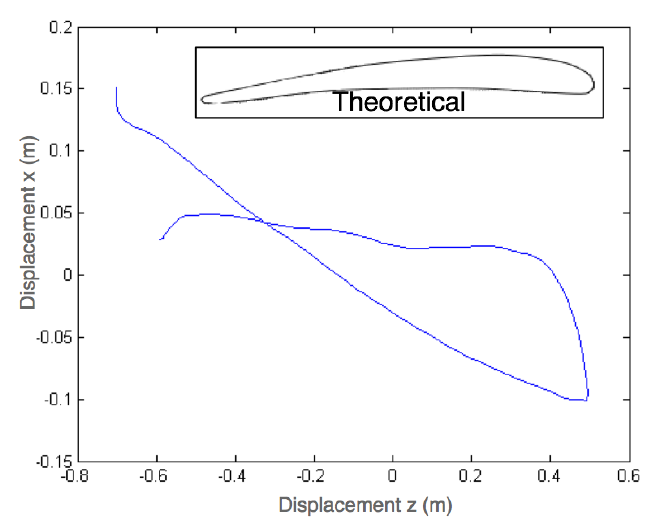
Figure 14. Inset: Theoretical trajectory of a stroke. Trajectory of a stroke obtained with the